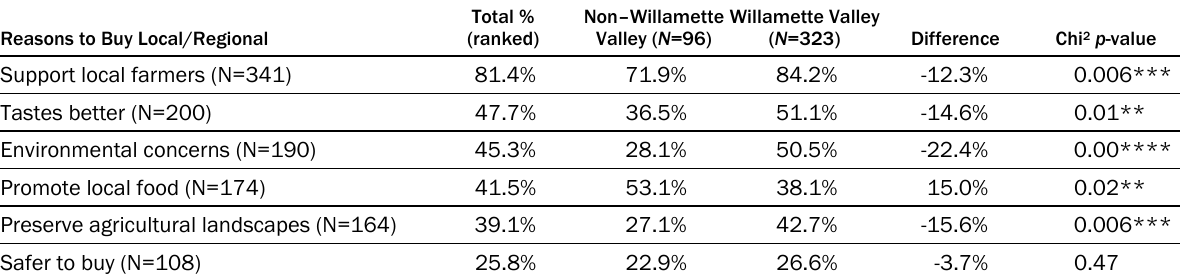
Table 5. Consumer Motivations for Buying Local/Regional Food, Ranked and by Region Reasons to Buy